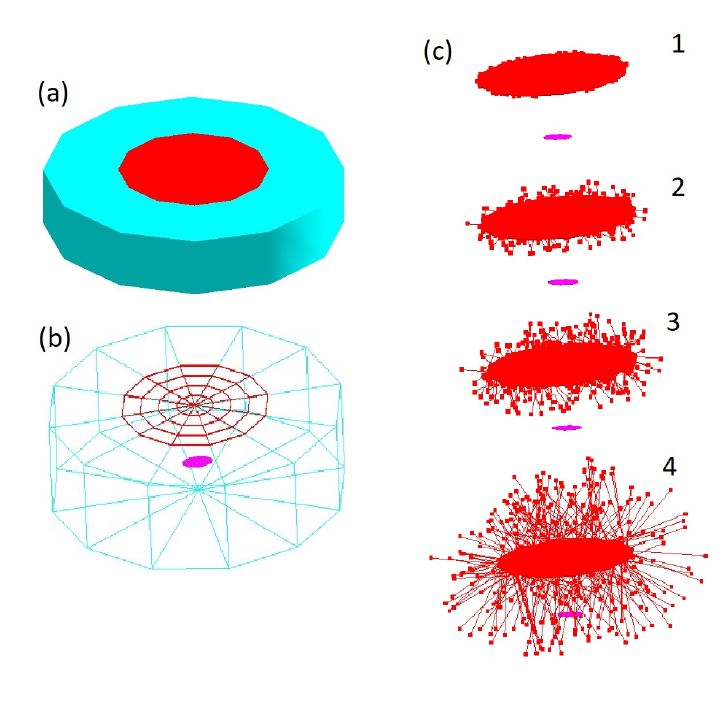
Figure 1. Out-of-scale computational scenario set up for simulation: The ocean salt water (blue color) and the spilled oil (red color) in solid (a) and in frame (b) pictures. In (c) a sequence of four images, without simulated ocean salt water, showing the interaction of oil radiation with matter. The magenta color geometry is the simulated